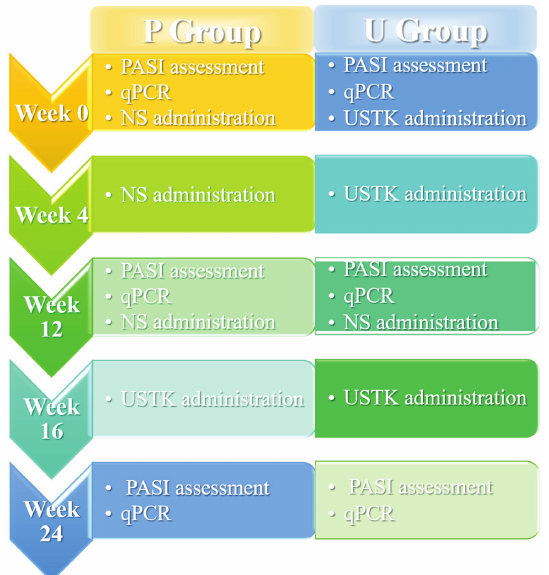
FIGURE 1 - Flowchart of the study. USTK: Ustekinumab. P Group: placebo group. U Group: Ustekinumab